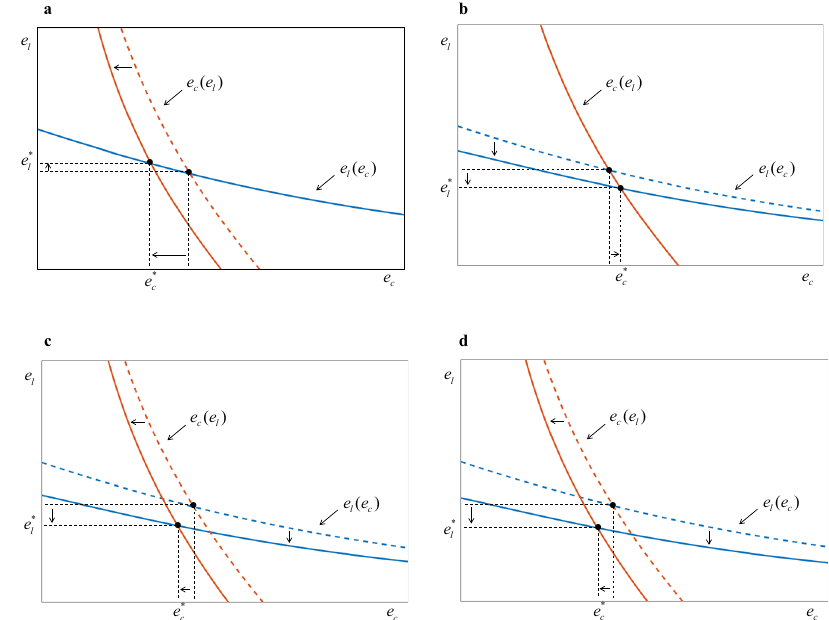
Fig.5 ComparativestaticsofNashequilibrium. a Increaseincostofeffortofcentralsupervisor. b Increase in liquidation costs of local supervisor. c Increase in expected asset return. d Decrease in volatility of asset